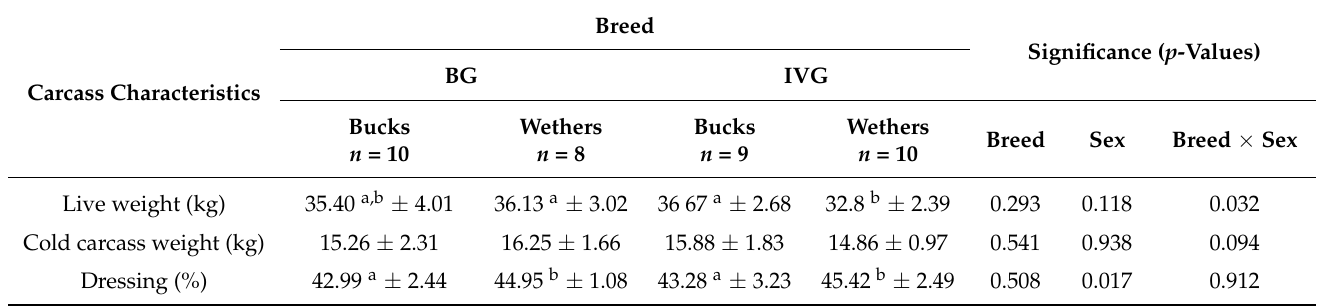
Table 1. Least square means and standard error (SE) of means for carcass characteristics of Boer- (BG) and large frame Indigenous Veld (IVG) buck and wether goats (adapted from [2]).